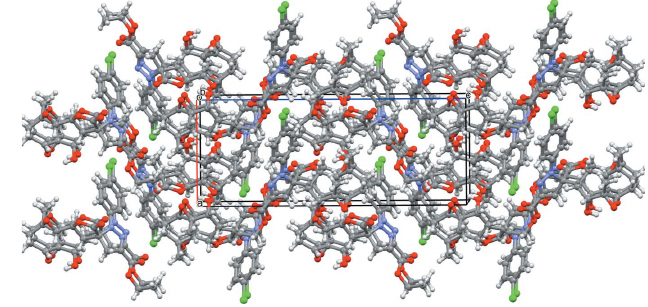
Figure 1 The title molecule with the atom-labelling scheme showing the intra- molecular hydrogen bonds (dashed bonds). Displacement ellipsoids are drawn at the 50% probability